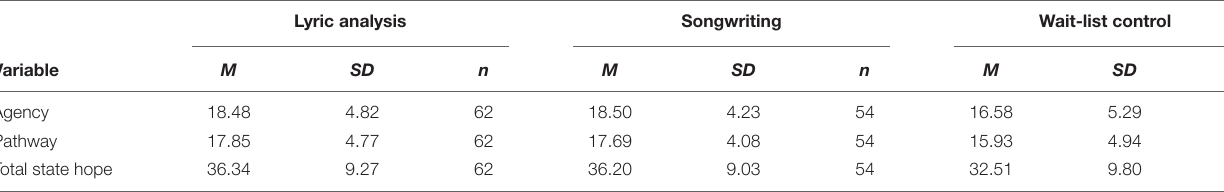
TABLE 3 | Descriptive statistics – state